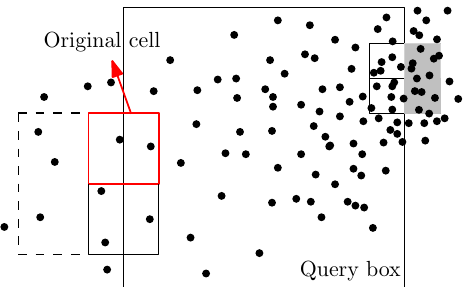
Figure 6. Various cell sizes computed by HistSFC when point density is variable in 2D data. The left two cells are merged into one bigger cell, while the right cell are split into four smaller ones with two totally out of the query